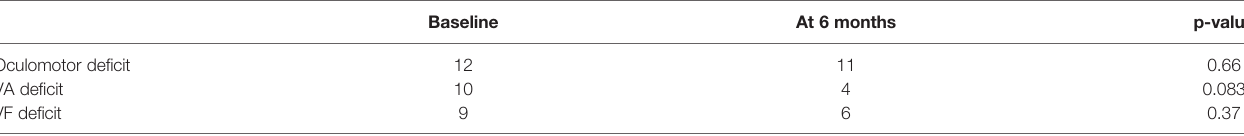
TABLE 3 | Clinical examination at 0 and 6 months.